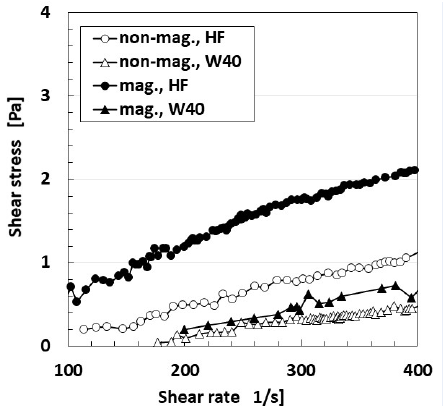
Figure 1. Relationship between shear rate and shear stress of HFs both without a magnetic field (non-mag.) and under a magnetic field of 39 mT (mag.).